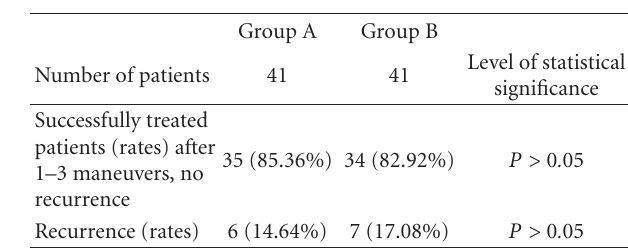
Table 3: Treatment outcome and